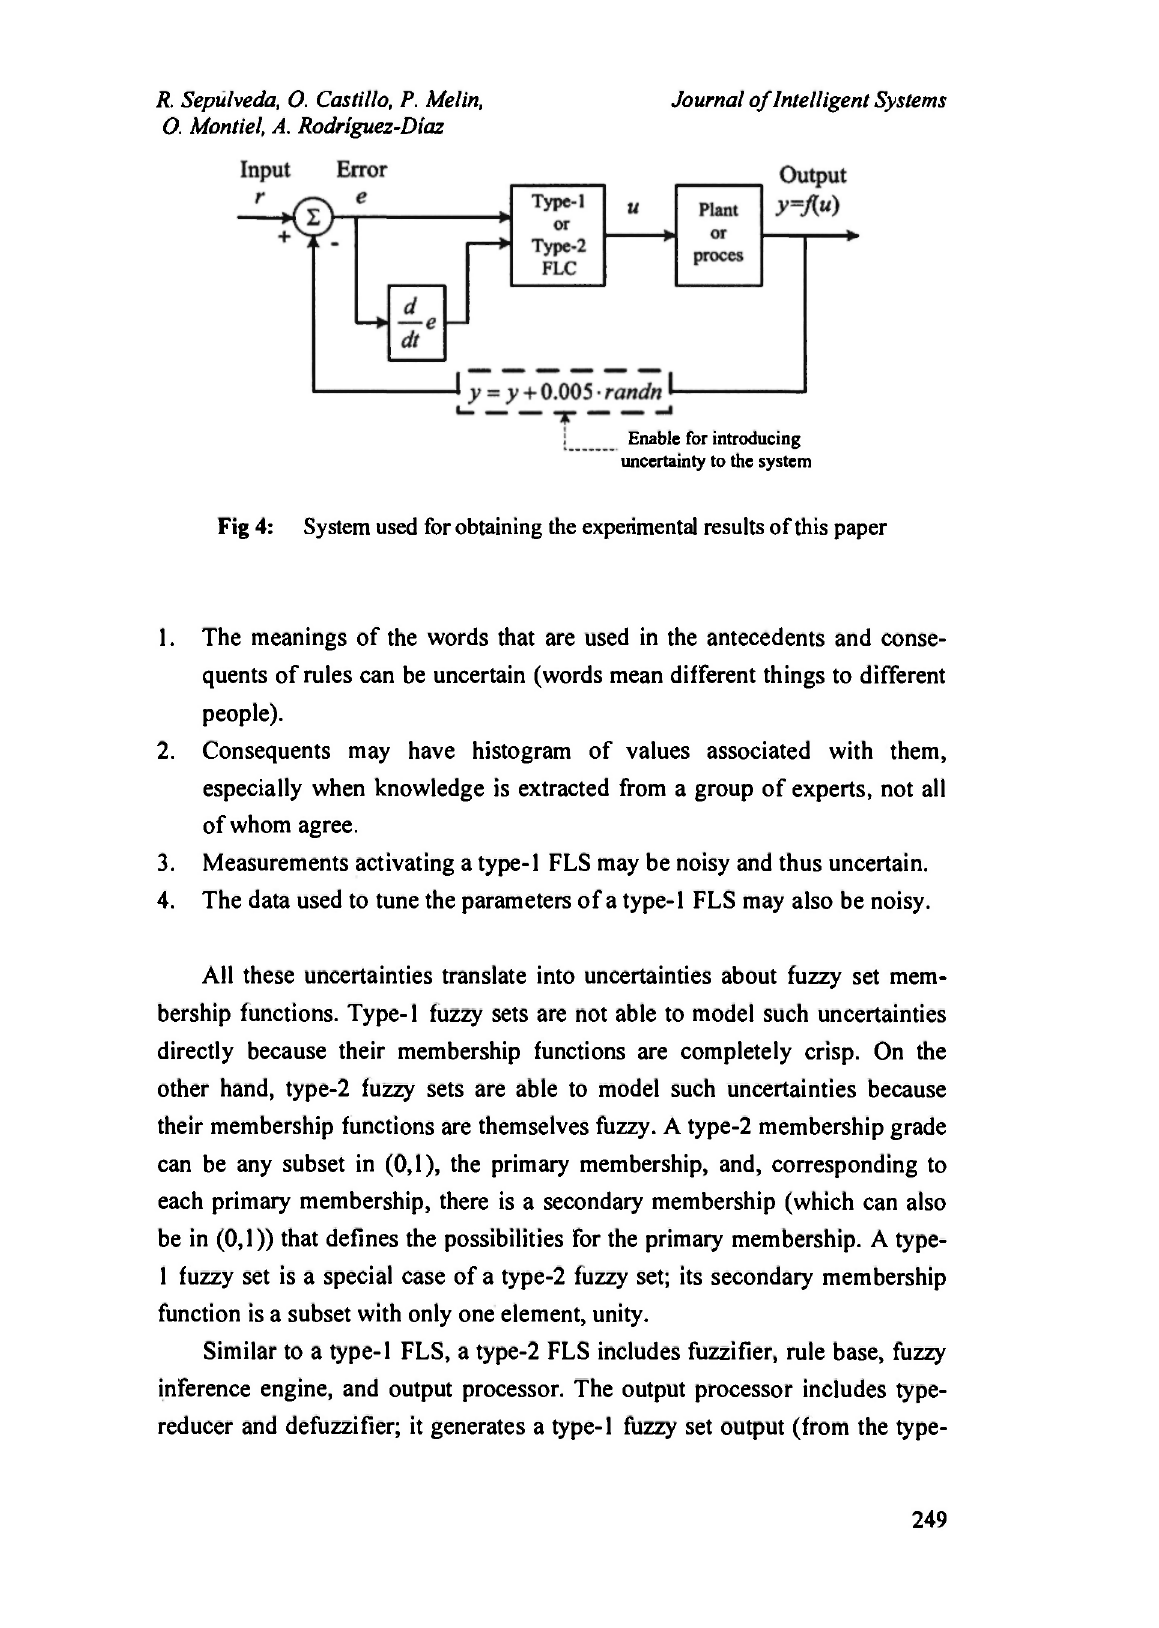
Enable for introducing uncertainty to the system